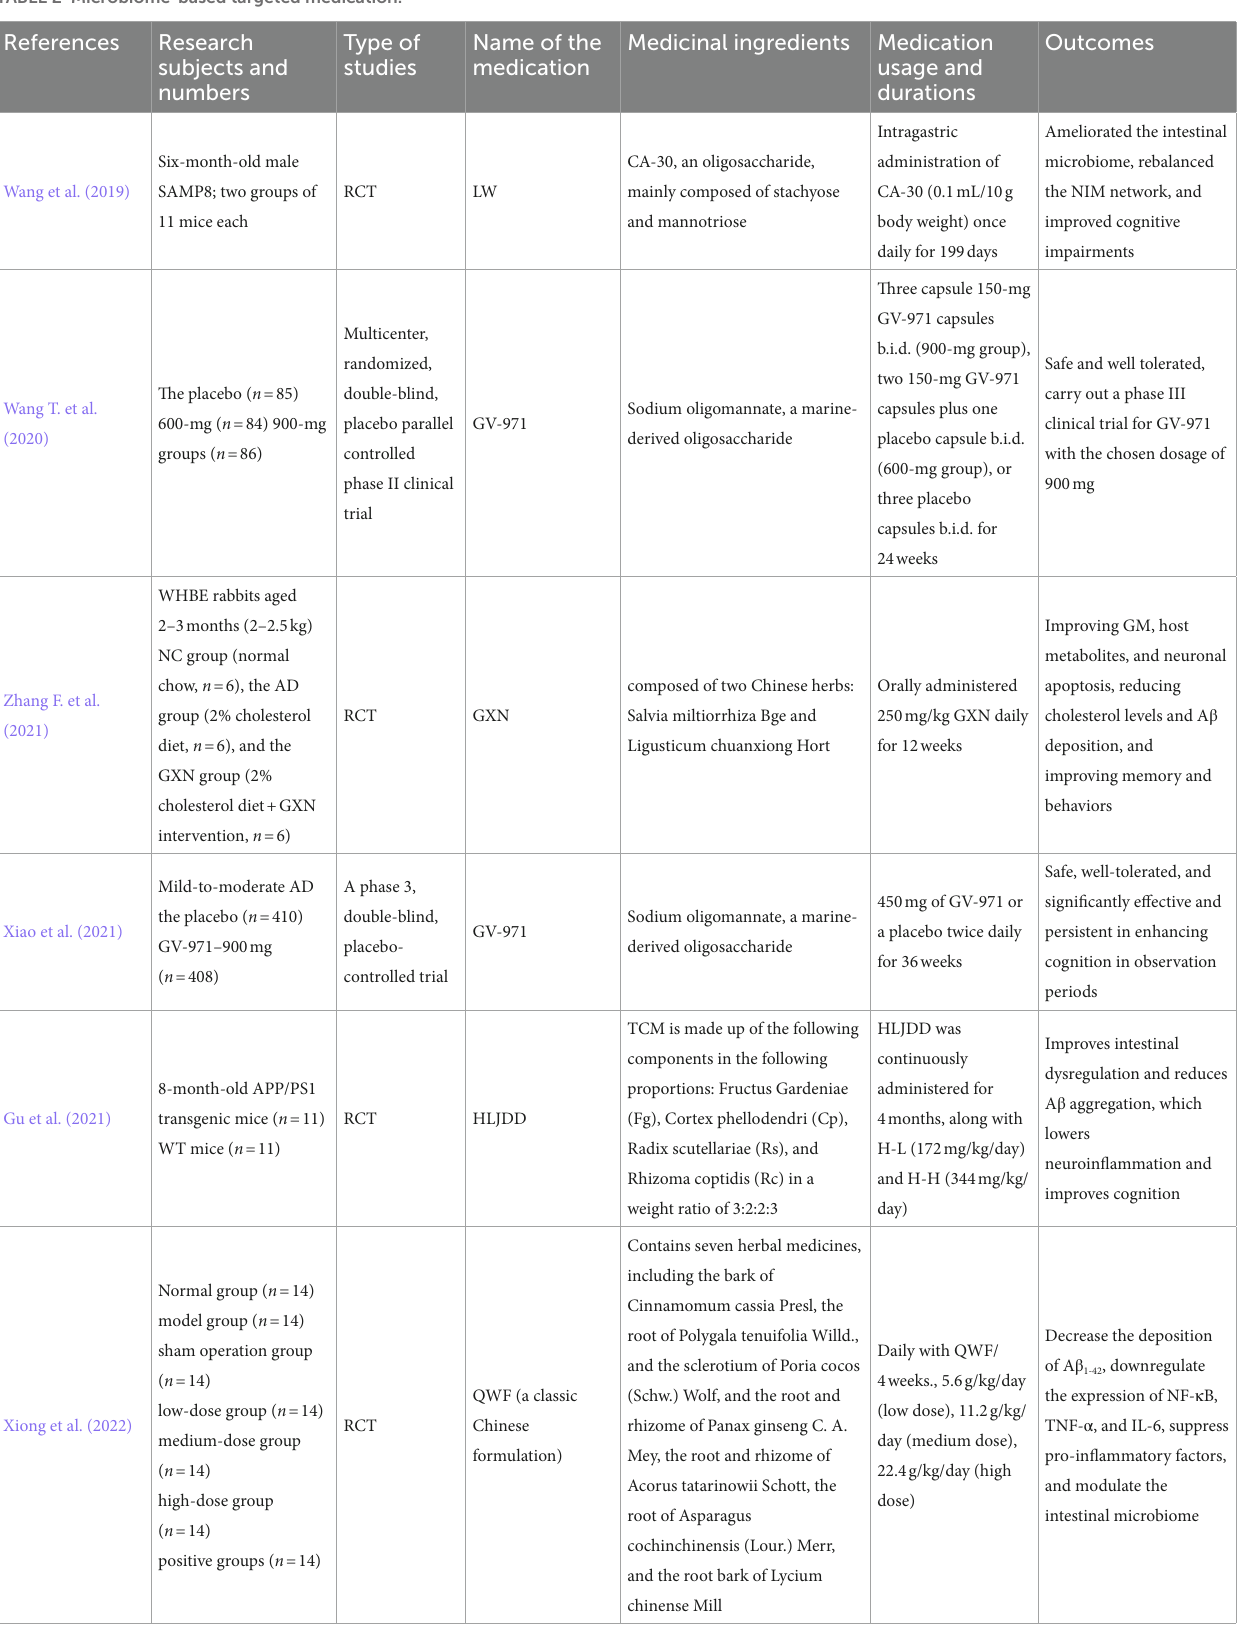
TABLE 2 Microbiome-based targeted